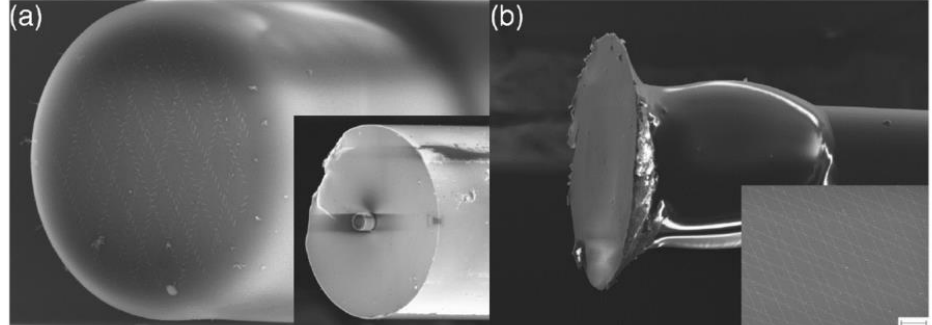
Figure 7. Micrograph images of patterned fibers. ( a ) Image of a polarimeter fabricated with the fiber exposure approach. ( b ) Image of a patterned fiber facet using the flood exposure approach, where a much larger area of nanoantennas arrays is transferred. Scale bar = 2 µ m. Reprinted with permission from Ref. [59]. Copyright 2019 IEEE Photonics Society.